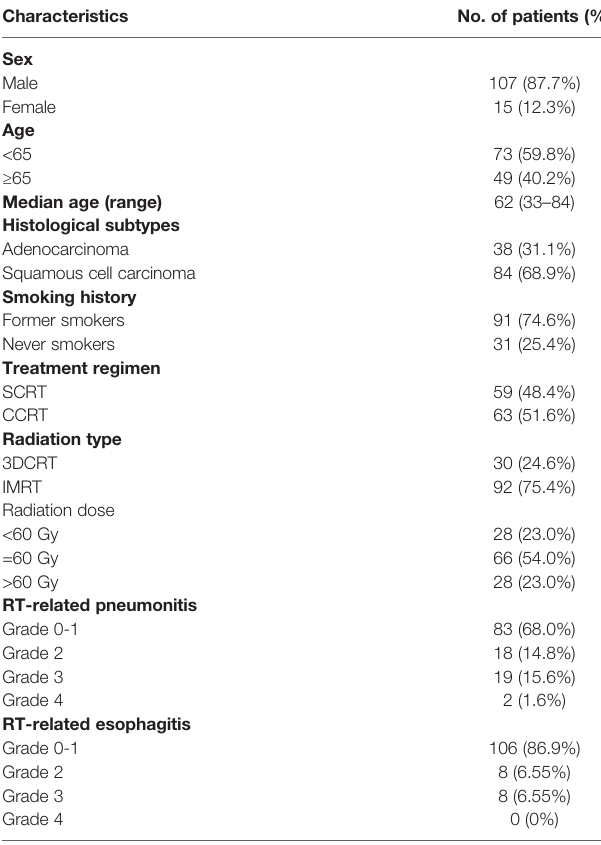
TABLE 1 | Clinical characteristics of the